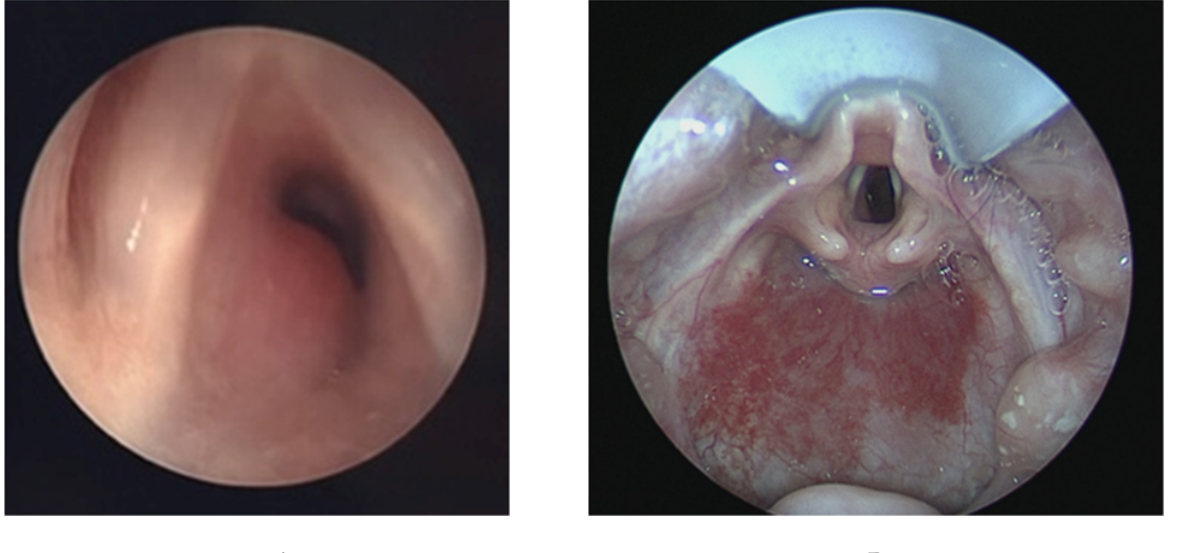
Figure 4. ( A ) Laryngoscopy image demonstrating large subglottic hemangioma obstructing a significant portion of subglottic airway. ( B ) This image demonstrates a more proximal view of the same patient’s airway showing improved subglottic patency after endoscopic treatment. Note the concomitant hypopharyngeal hemangioma.